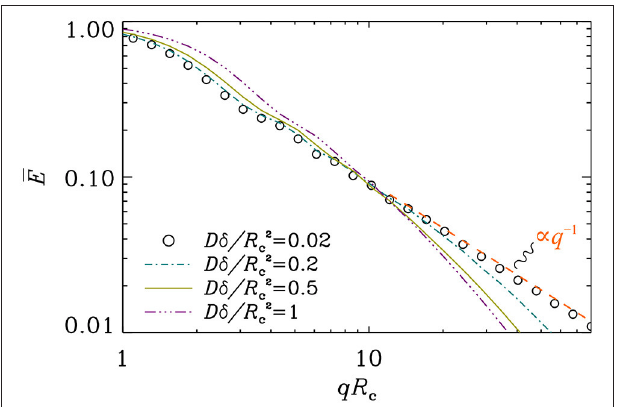
FIGURE 3 | Signal attenuation curves for different values of the pulse duration. The separation of pulses was taken so that D 1 at short pulse durations, disappears as the pulses are